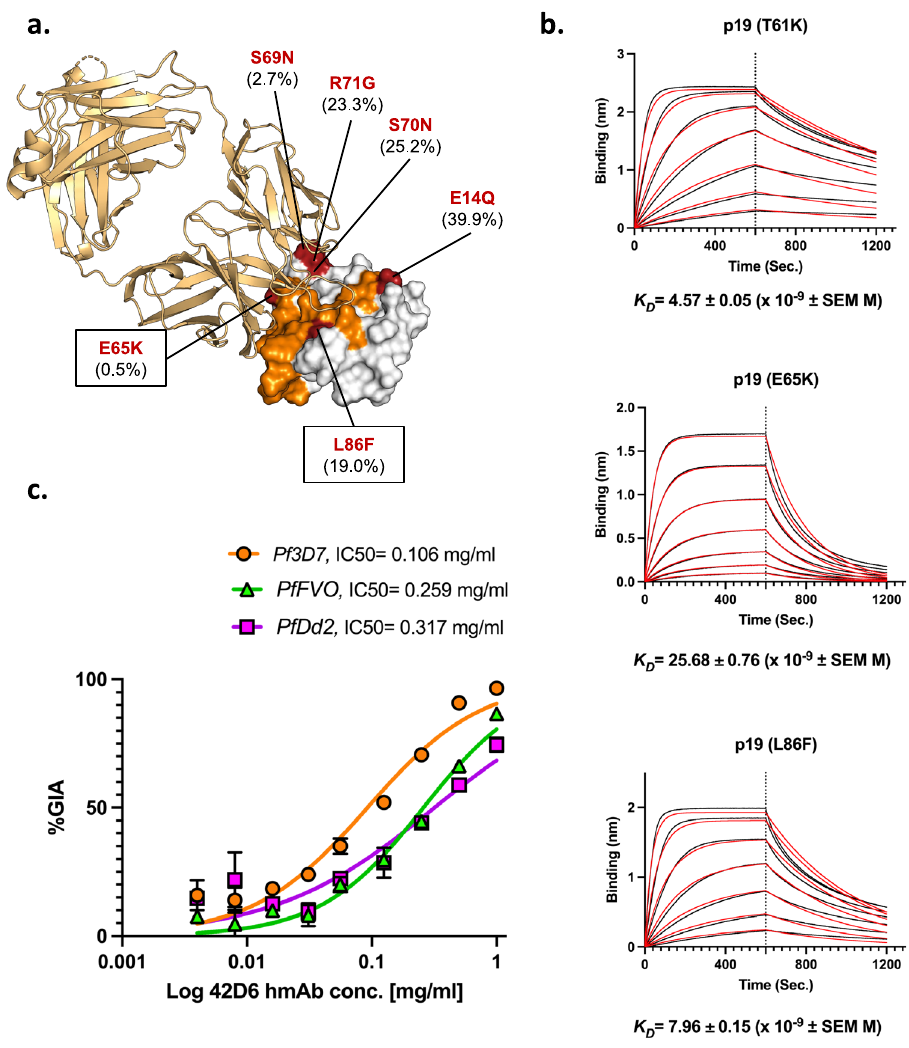
Fig. 3 | Human mAb 42D6 targets a conserved epitope on p19. a p19 sequence polymorphisms. Polymorphism mapped onto the p19 surface. 42D6 epitope is colored in orange. Polymorphic residues are shown in red and the observed sub- stitutions as well as the percent minor allele frequency (MAF) of substitutions are indicated. p19 is represented as white surface and 42D6 Fab fragment as bright orange cartoon. b Binding af fi nity of 42D6 Fab to p19 constructs with point mutations representative of sequence polymorphisms in the 42D6 epitope as